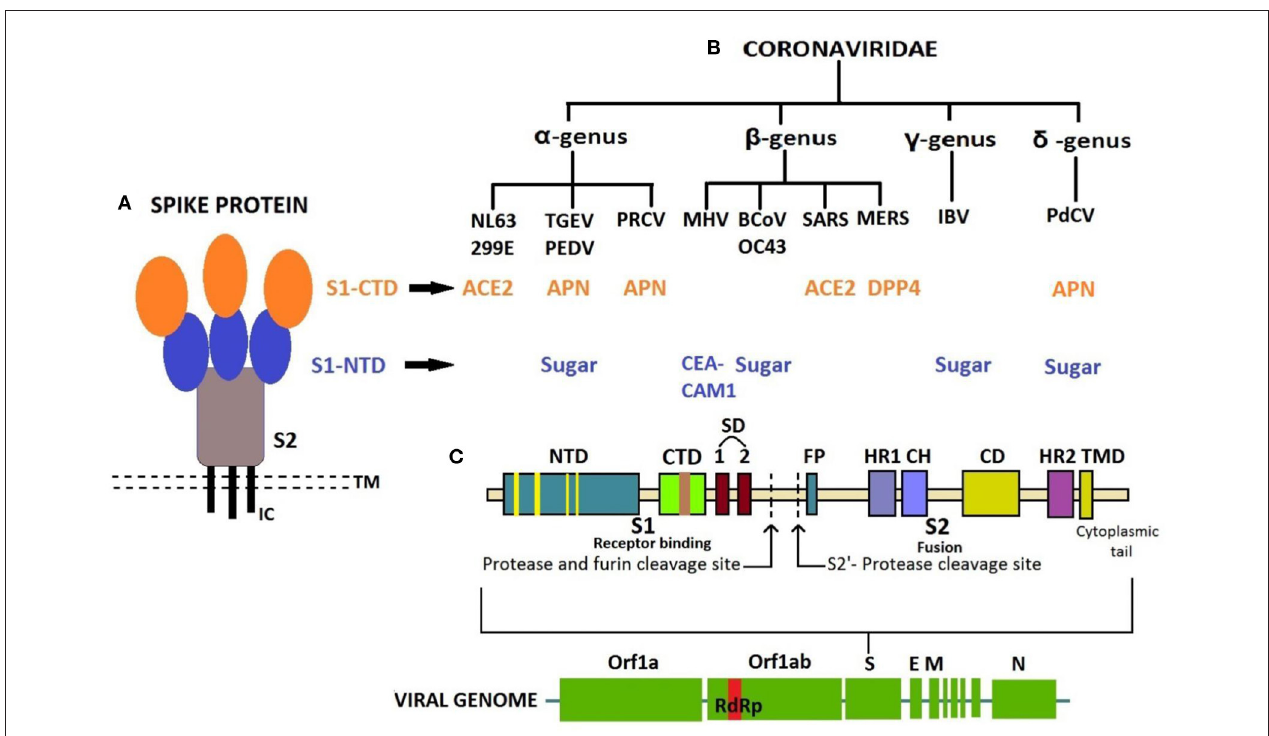
FIGURE 3 | (A) Structure of Spike protein. (B) Classification of coronaviruses based on host cell recognition pattern by spike protein. (C) Genome organization of coronavirus and single S protein, from N- to C-terminus in left-to-right orientation. N-terminal domain in blue with receptor-binding motif (RBM) in yellow; C-terminal domain in green with RBM in brown. CTD, C-terminal domain; NTD, N-terminal domain; TMD, Transmembrane domain; IC, Intracellular tail; ACE2, Angiotensin-converting enzyme 2; APN, Aminopeptidase N; CEACAM1, Carcinoembryonic antigen-related cell adhesion molecule 1; DPP4, Dipeptidyl peptidase 4; SD, Subdomain; FP, Fusion peptide; HR1, Heptad repeat 1; HR2, Heptad repeat 2; CH, Central helix; CD, Connector